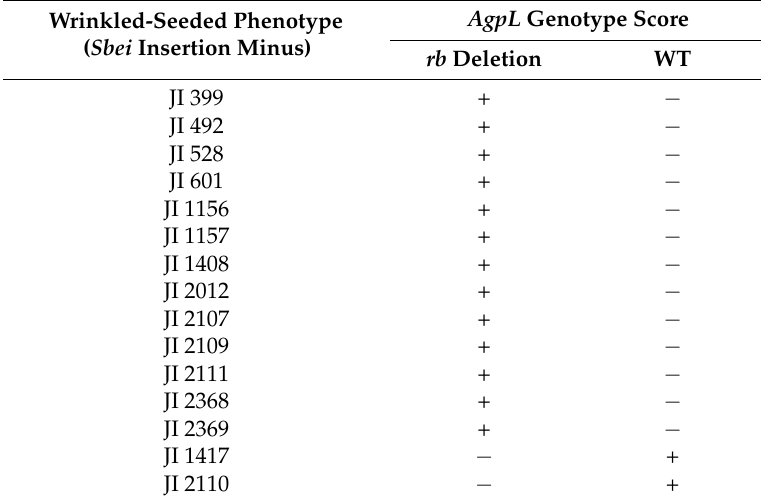
Table 2. The identities of 15 germplasm accessions, lacking the sbeI insertion mutation, of which 13 are rb and two (JI 2110, JI 1417) are neither r or rb . WT, wild type AgpL score, where the deletion is absent ( − ); the deletion was present in lines shown with a +